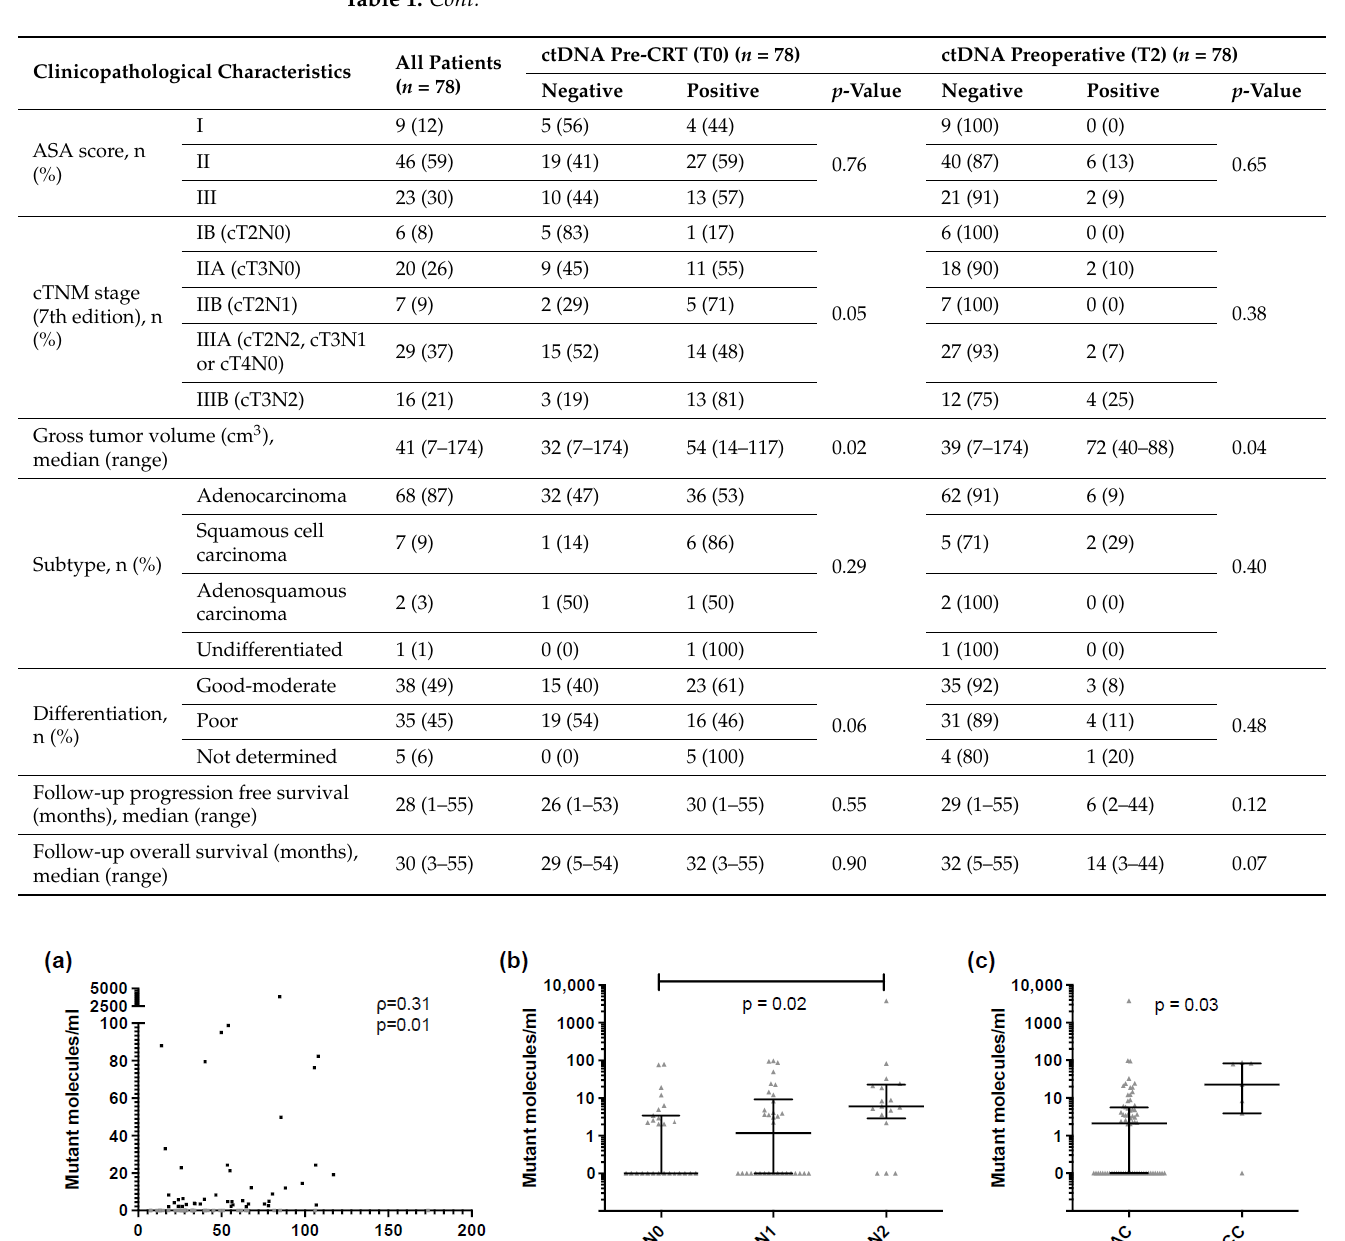
3a). In patients with detected ctDNA, 100% (13/13) of tumor-informed mutations were